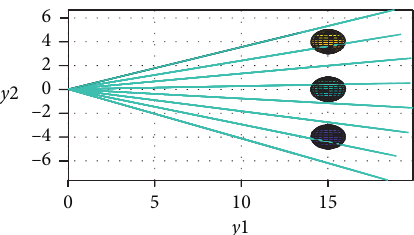
Figure 13: Vertical projection of the 3D lidar’s view for five scattered obstacles in 15m.